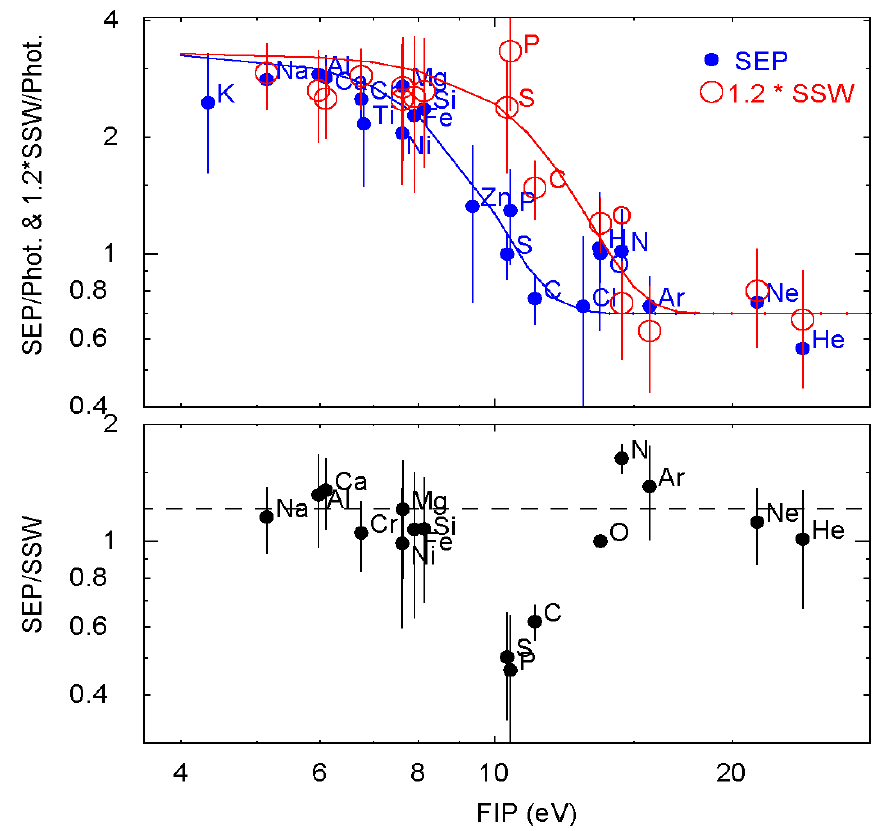
Figure 8. The lower panel shows the SEP / slow solar wind (SSW) abundance ratio vs. FIP for the elements named. The dashed line shows a preferred ratio of ≈ 1.2. The upper panel shows SEP and 1.2*SSW abundances relative to the photosphere vs. FIP with empirical curves to show the trend of the data [13,59]. See Appendix for numerical values.